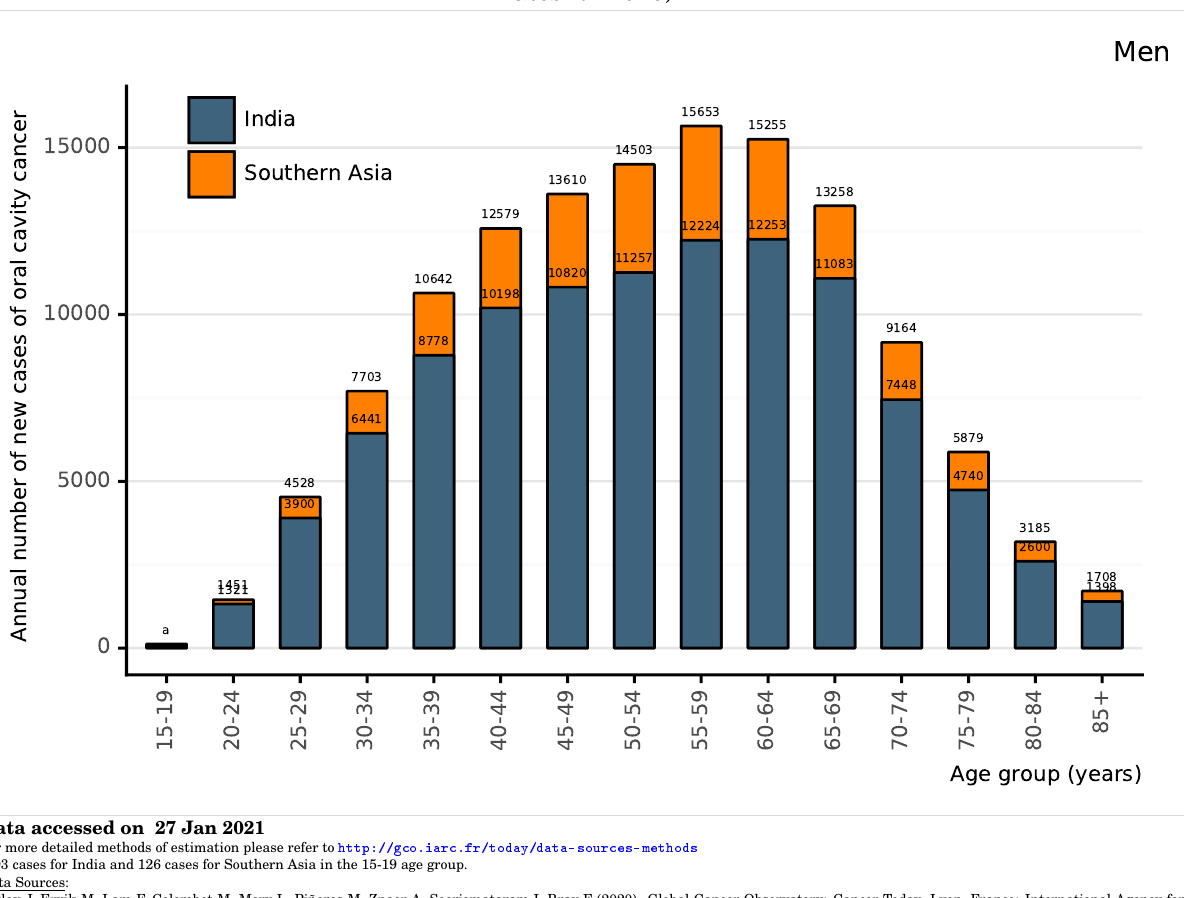
Figure 96: Annual number of new cases of oral cavity cancer among men by age group in India (esti- mates for